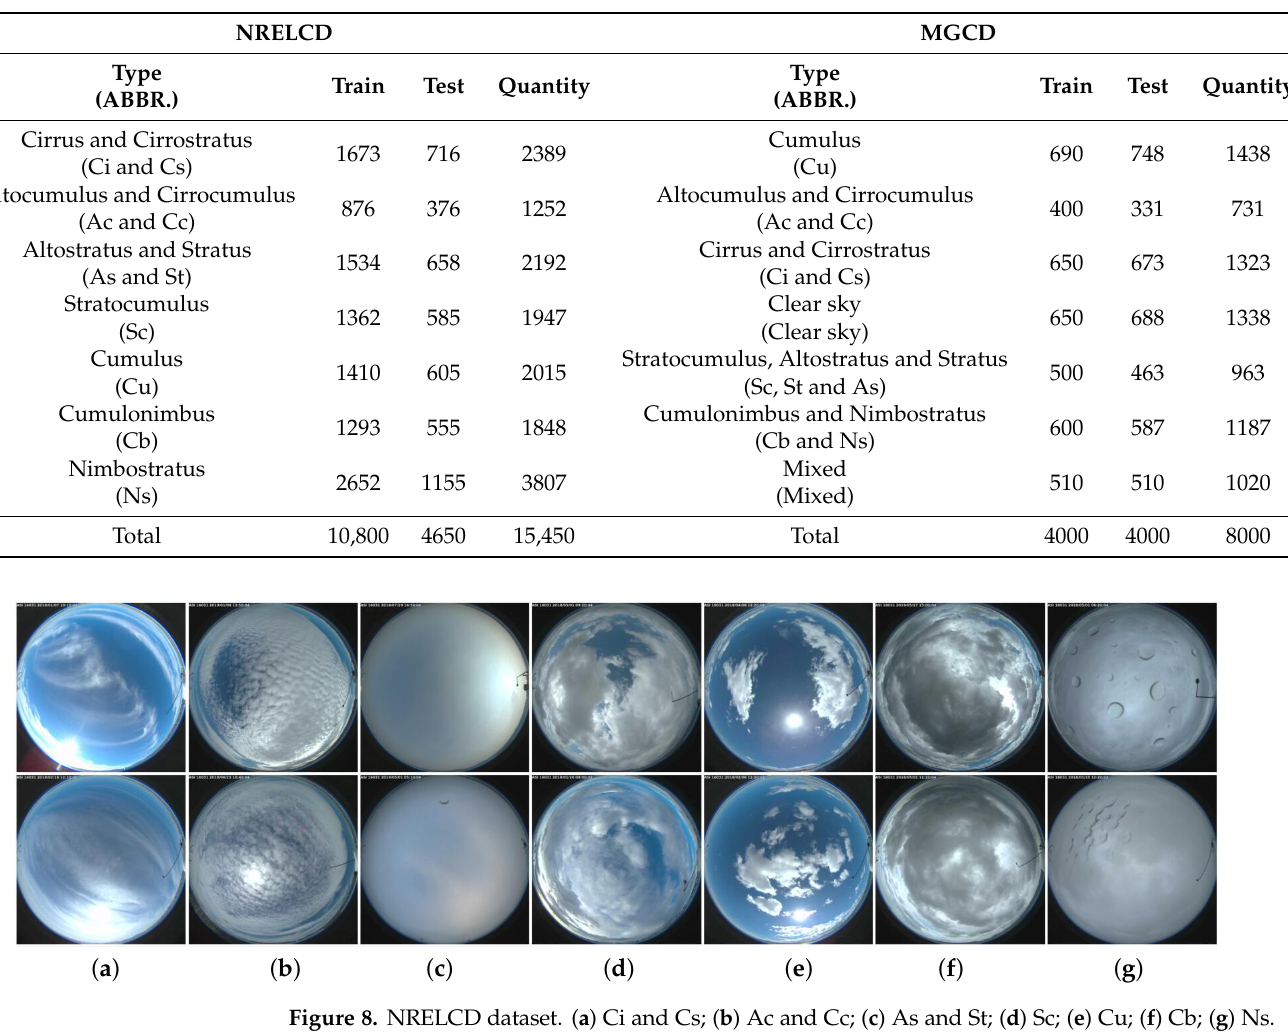
Figure 8. NRELCD dataset. ( a ) Ci and Cs; ( b ) Ac and Cc; ( c ) As and St; ( d ) Sc; ( e ) Cu; ( f ) Cb; ( g ) Ns.